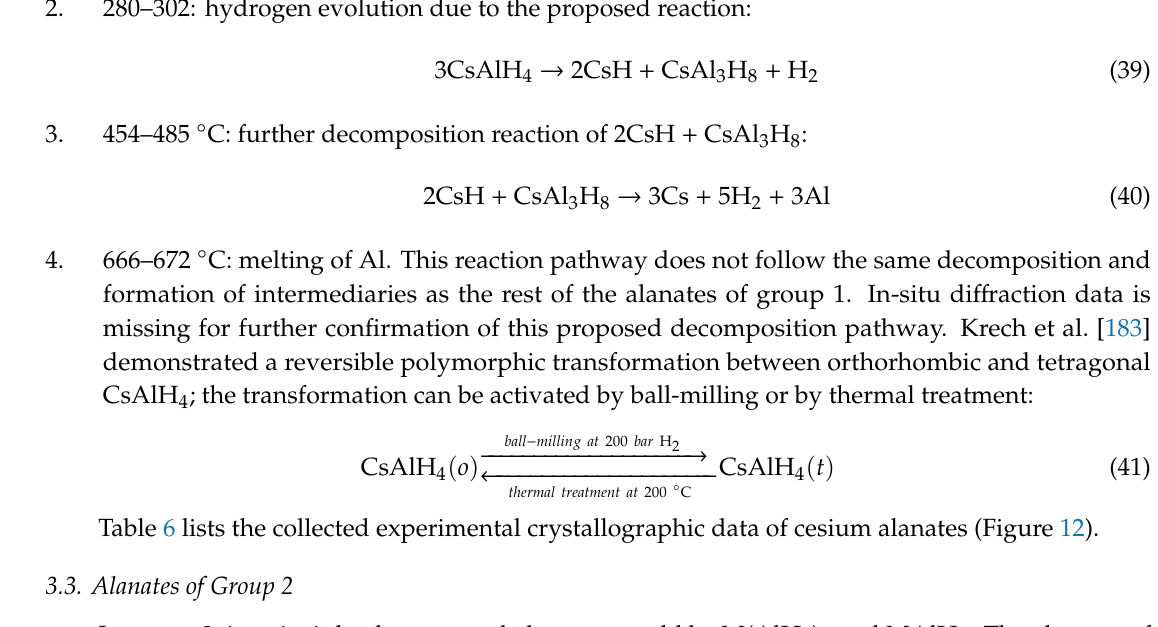
Figure 11. Crystal structure of rubidium alanates and their calculated diffraction patterns ( λ = Cu k α 1 ).